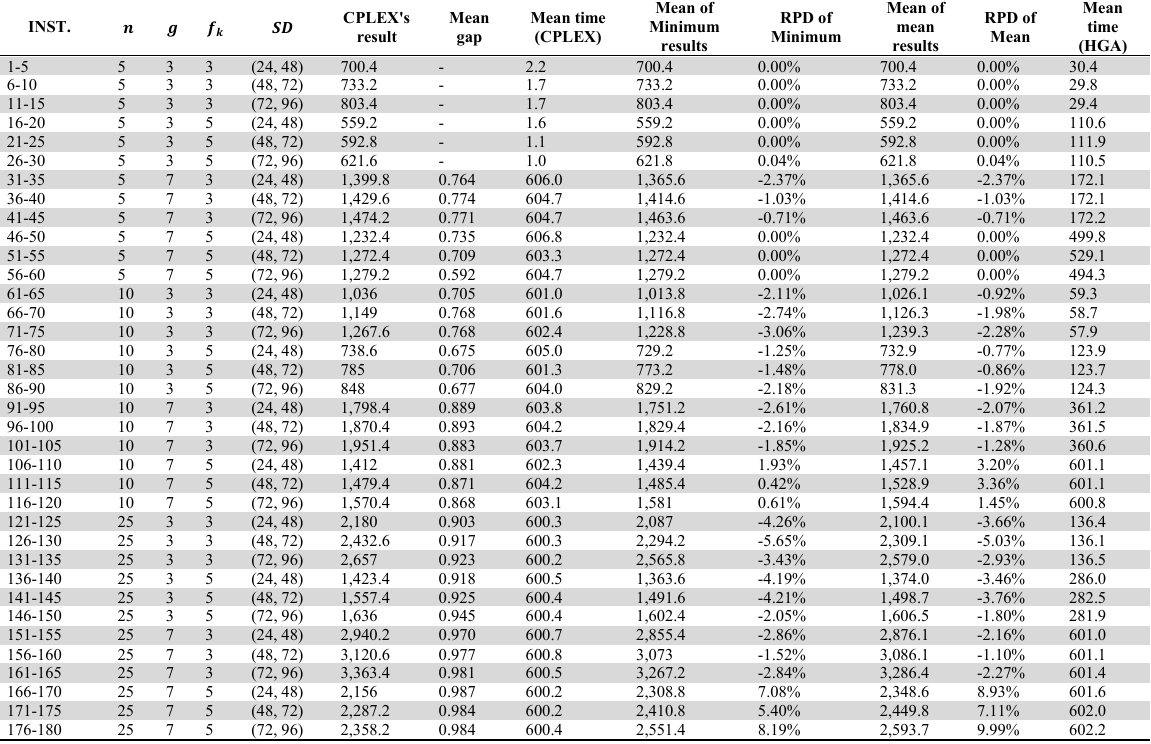
Comparison of results